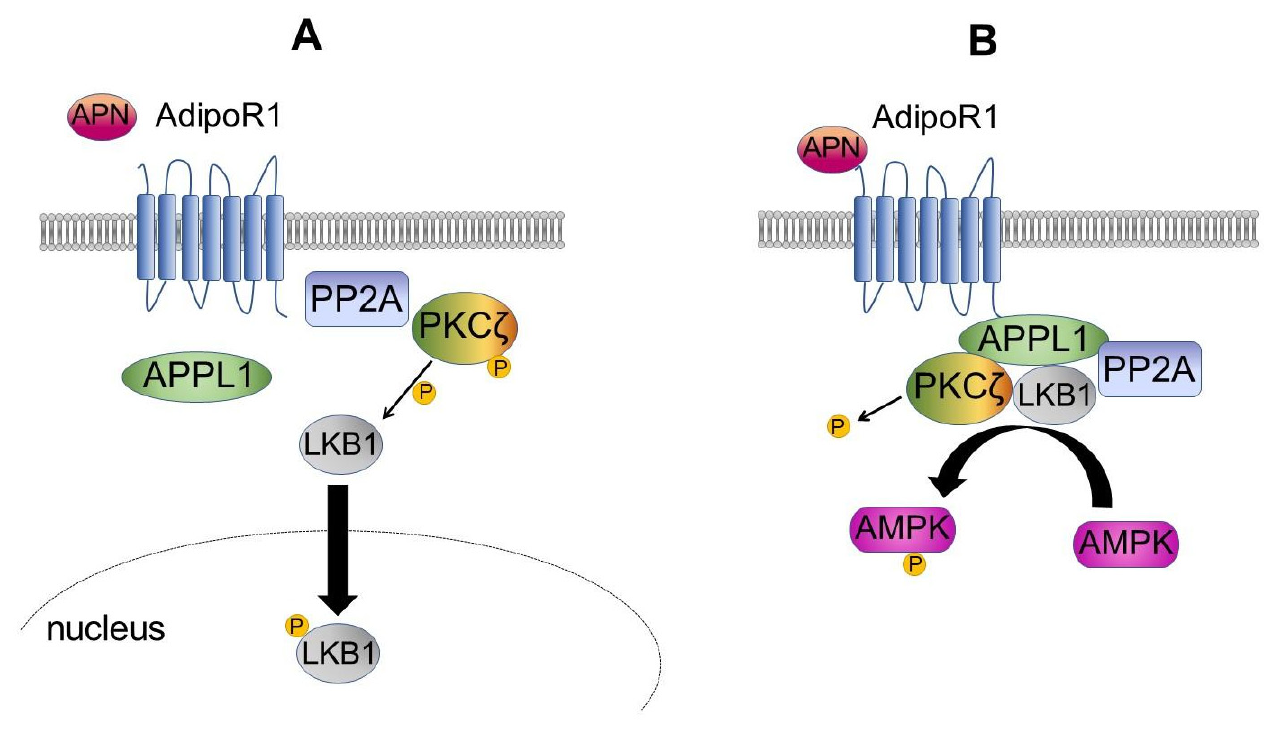
Figure 1. Mechanism of adiponectin-dependent AMPK activation. ( A ) In the non-stimulated state, APPL1 and protein phosphatase 2A (PP2A) do not interact. Protein kinase C ζ (PKC ζ ) phosphorylates liver kinase B 1 (LKB1) and induces its translocation to the nucleus. ( B ) Upon adiponectin (APN) binding, PKC ζ is dephosphorylated by PP2A. Dephosphorylated PKC ζ is no longer able to phosphorylate LKB1. PP2A also dephosphorylates LKB1, which results in LKB1 translocation to the cytoplasm. LKB1 phosphorylates AMP-activated protein kinase (AMPK) in the form of the AdipoR1/APPL1/PP2A/ PKC ζ /LKB1 complex.